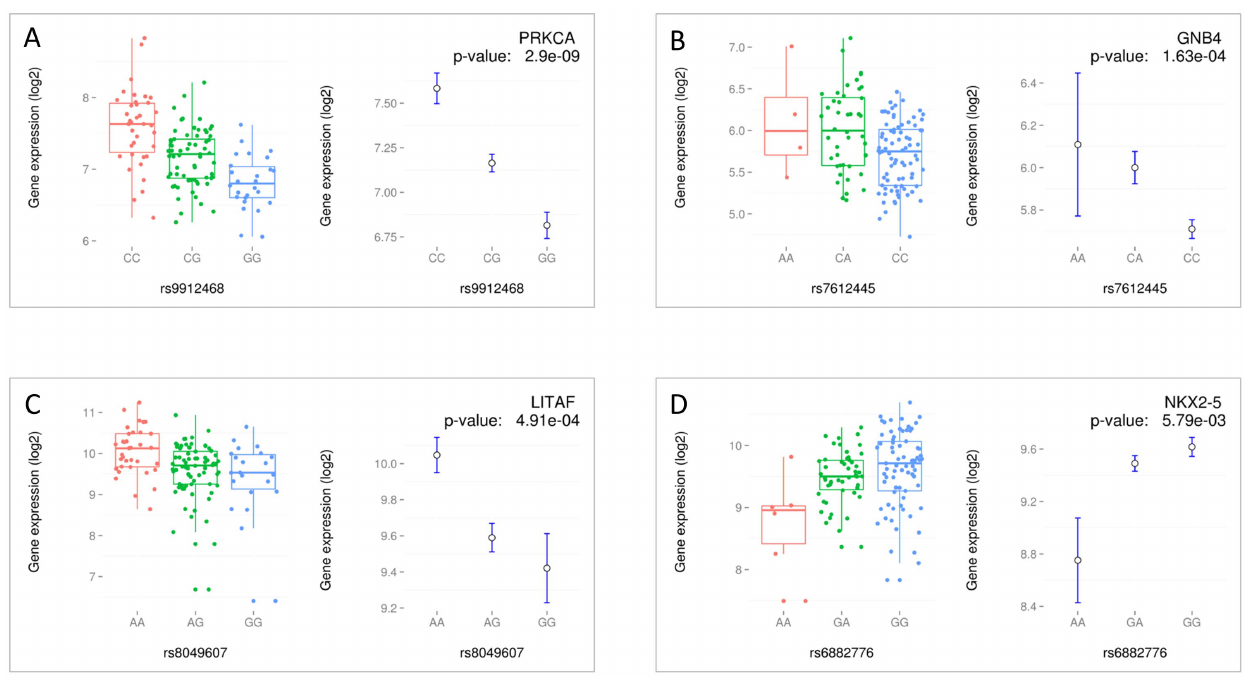
Figure 2. eQTL overview plots for 4 cardiac trait GWAS candidate genes. An overview of 4 GWAS cis eQTLs: rs9912468 with PRKCA (panel A), rs7912445 with GNB4 (panel B), rs8049607 with LITAF (panel C) and rs6882776 with NKX2-5 (panel D). On the left of each panel, box-and-whisker plots of mRNA levels for all genotypes. On the right, mean and standard-error plots of mRNA levels for all genotypes are illustrated. Right upper corner gives the association p-value and the gene name.